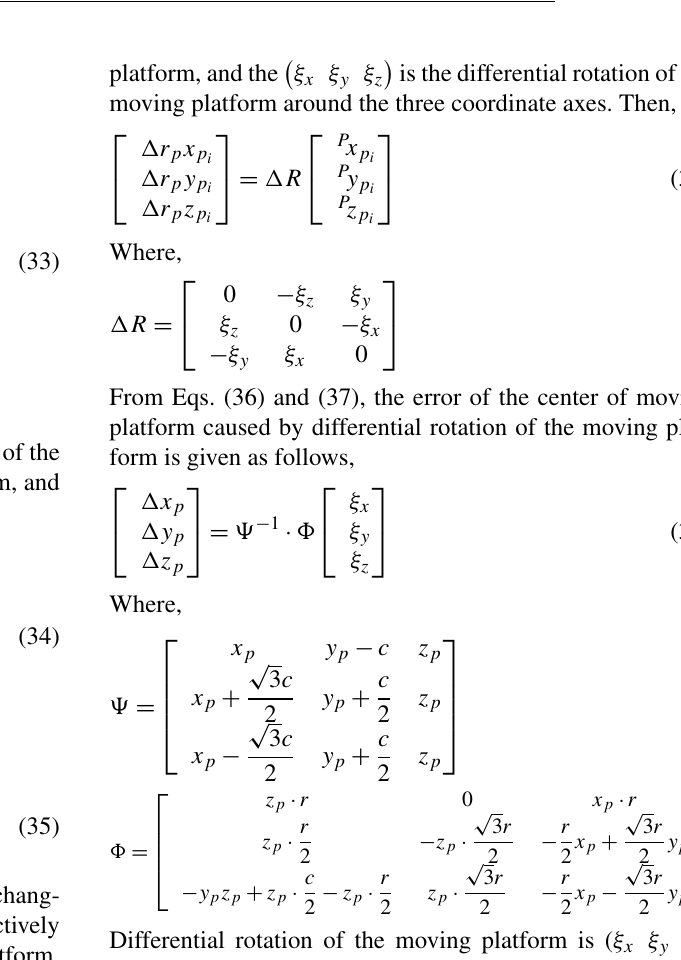
Table 2. Statistical parameters of the influence in the different positions of the position errors by error independent method. E ( X ) σ 2 ( x ) E ( Y ) σ 2 ( y ) E ( Z ) σ 2 ( z ) E ( dt p ) σ 2 ( dt p ) Figure 7 0.0013 0.0012 − 0 . 0381 0.0018 0.00070 0.00021 0.0412 0.0068 Figure 8 − 0 . 0030 0.0020 0.0400 0.0020 0.00042 0.00024 0.0496 0.00075 Figure 9 0.0161 0.0005 0.0318 0.0028 0.00019 0.00082 Figure 10 0.0020 0.0011 0.0377 0.0064 − 0 . 00071 0.00031 0.0403 0.00034